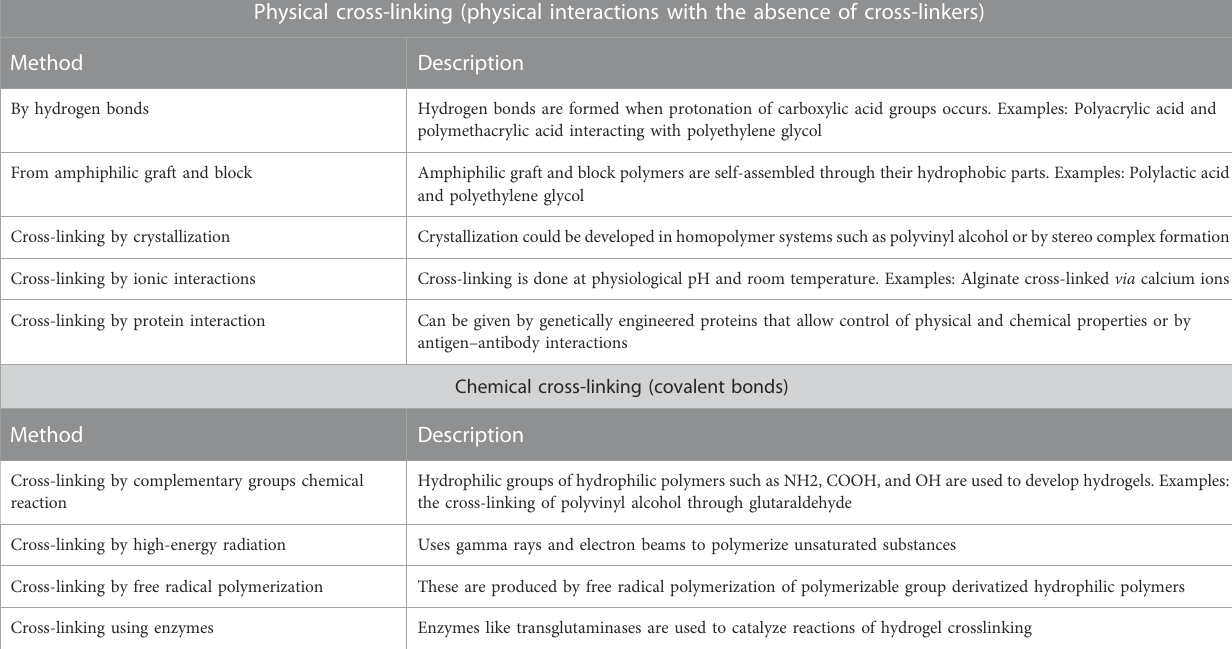
TABLE 1 According to Akhtar, et al. methods for hydrogel synthesis can be divided into physical cross-linking and chemical cross-link (Akhtar et al., 2016). Physical cross-linking (physical interactions with the absence of